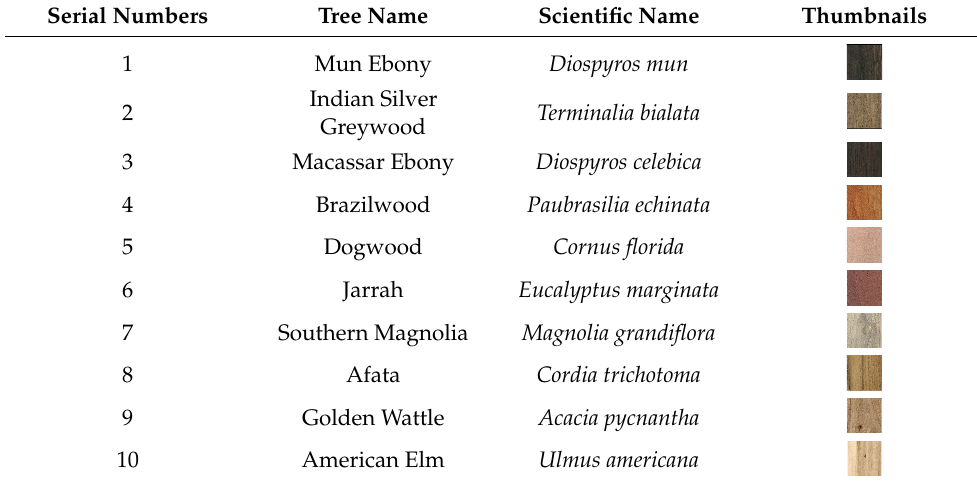
Table 1. Basic information of the ten tree species.